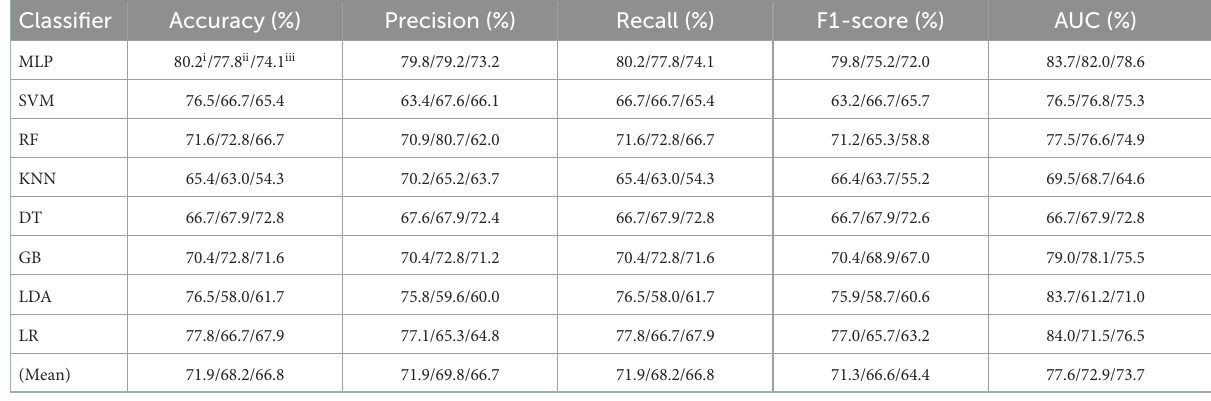
TABLE 1 Evaluation metrics of the different classifiers with three original features (Experiment 1) on the test set.